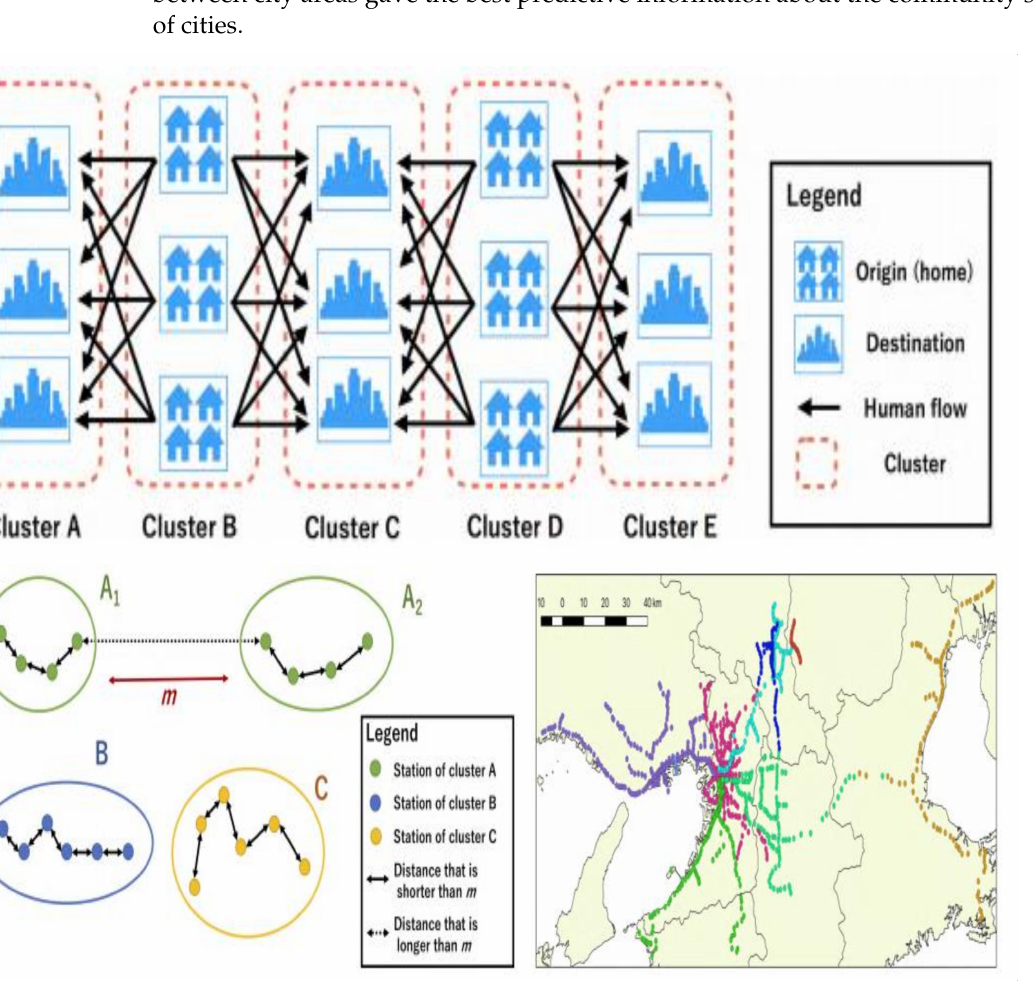
Figure 22. Network clustering for community structures